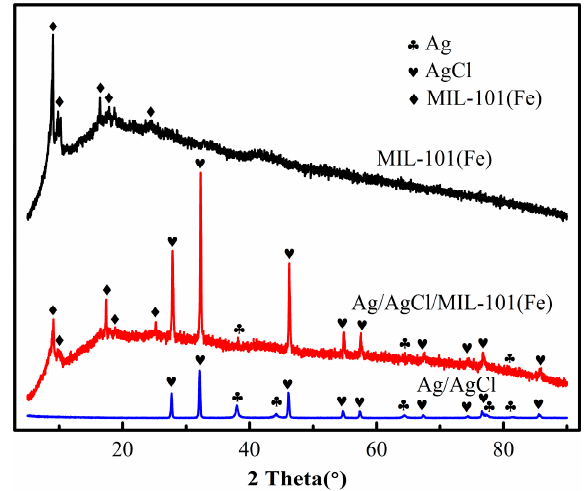
Figure 1. X ‐ ray diffraction patterns of the Ag/AgCl, MIL ‐ 101(Fe) and Ag/AgCl/MIL ‐ 101(Fe).